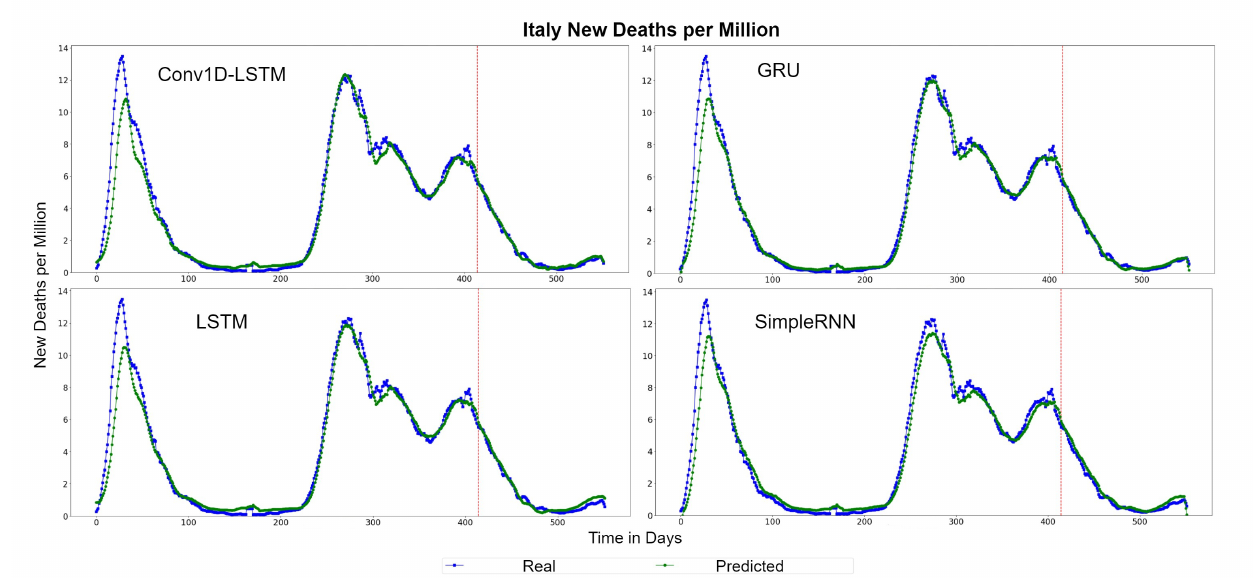
Figure 10. Italy’s new deaths per million real (blue line) and predicted (green line) values for each method, using the training, validation and test datasets. The red line divides the train-validation (right size) and the test (left side)